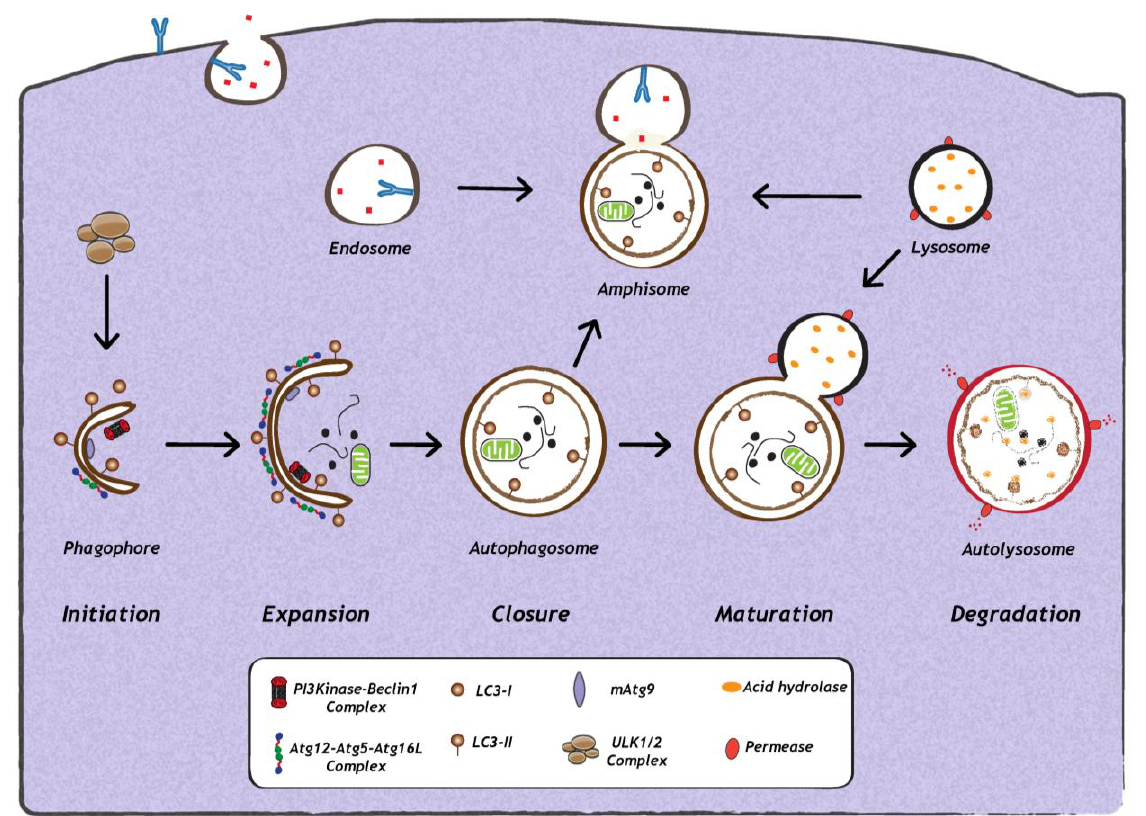
Figure 1. Schematic representation of autophagy. The first step in the initiation of mammalian autophagy is the formation of the phagophore, followed by subsequent steps, which include elongation and expansion of the phagophore, closure and completion of a double-membrane